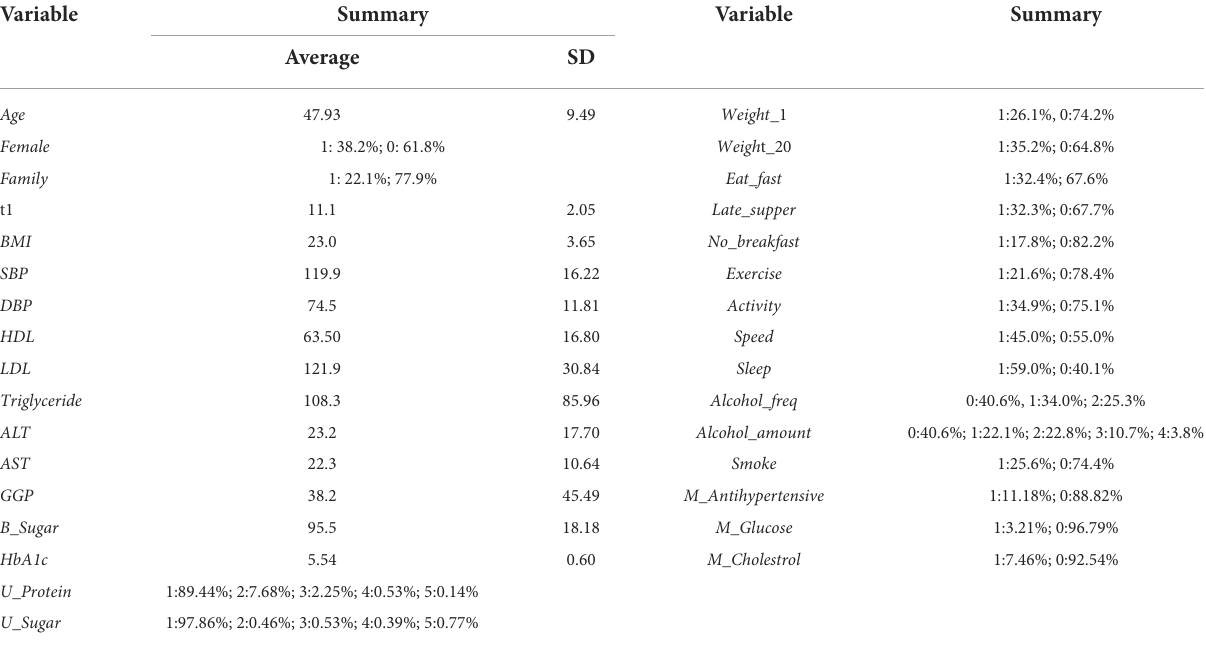
TABLE 4 Summary of